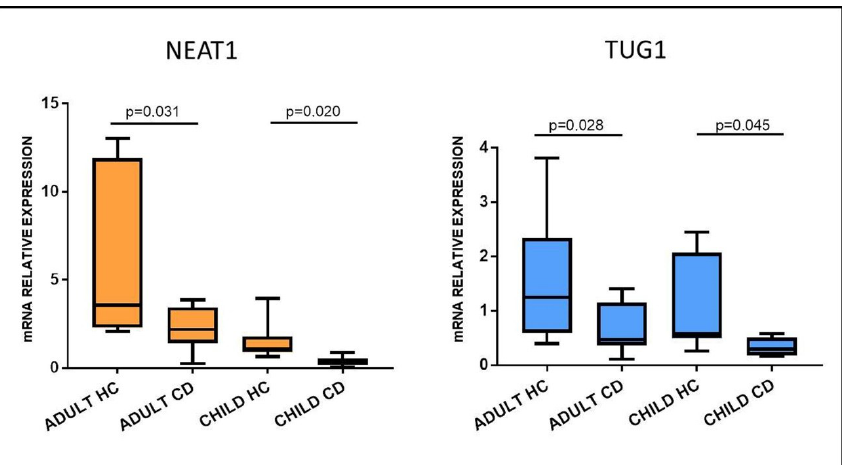
Figure 3. NEAT1 and TUG1 mRNA expression in duodenal biopsies of adult and pediatric Marsh 3C celiac patients (CD) compared to matched healthy controls (HCs). Adult HCs n = 7; adult CD n = 10; child HCs n = 10; child CD n = 6. Data are expressed as box plots indicating 25–75th percentile and median value, with whiskers representing 5th and 95th percentile.